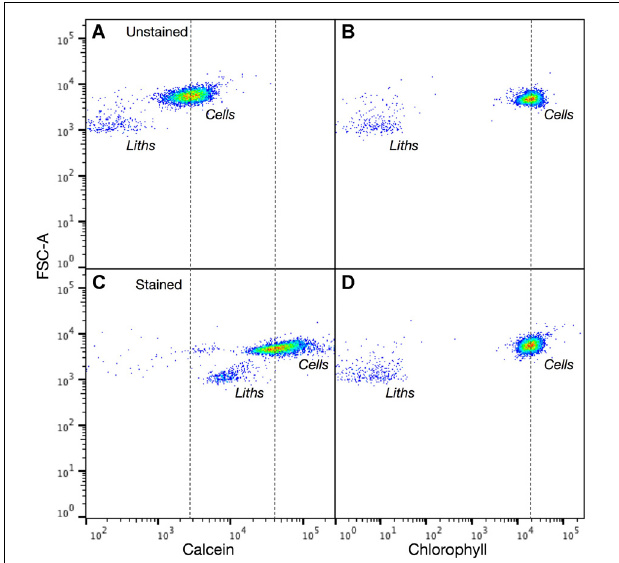
FIGURE 8 | Calcein labeled and unlabeled Emiliania huxleyi cells are readily detected using flow cytometry. Intensity dot plots of (A) calcein and (B) chlorophyll signals vs. forward scatter (FSC-A) for unstained E. huxleyi cells. (C,D) Intensity dot plots of calcein and chlorophyll channels for cells after 2 h staining with calcein. Both cells and detached coccoliths are readily identified in each channel. For chlorophyll there is no change in the distribution of unstained and stained cells or coccoliths (dotted line for reference). The stained and unstained populations of cells and coccoliths are clearly distinguished in the calcein channel (dotted lines for reference). 5,000 events counted.